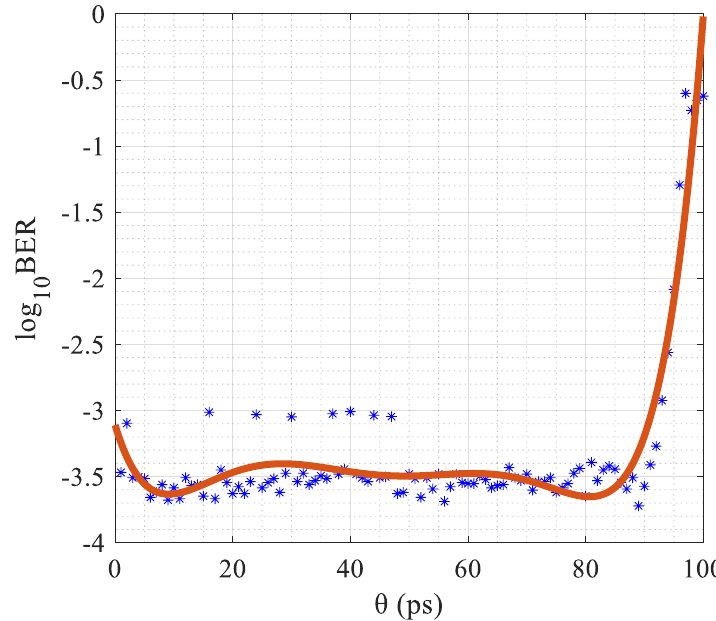
Figure 5. Schematic diagram of the input signal pre-processing process.